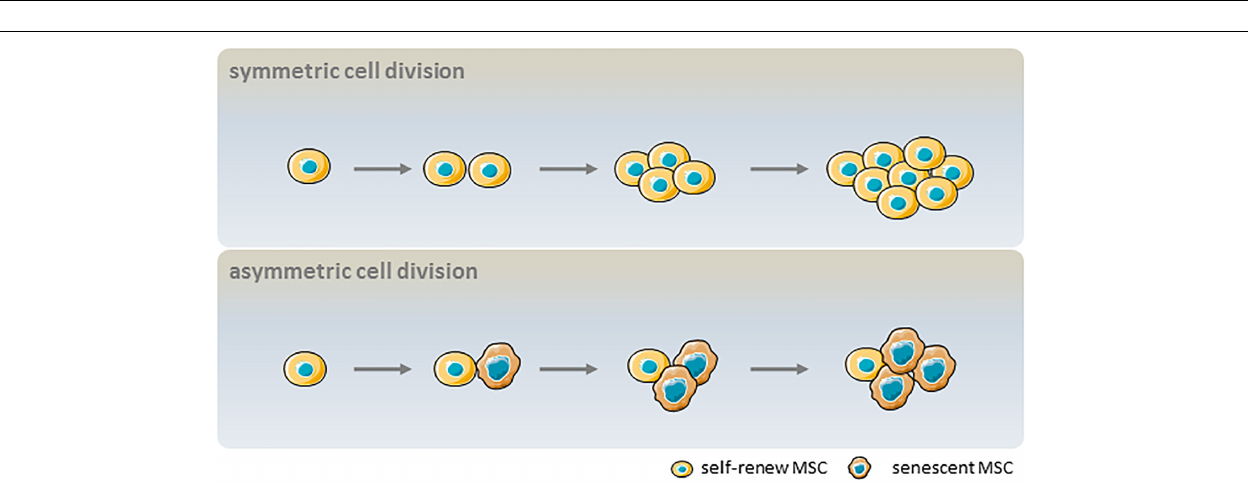
FIGURE 2 | Phenotypic features of senescent MSCs. In vivo and in vitro aging lead to MSC senescence, which is characterized by heterogeneity, biological and functional changes.